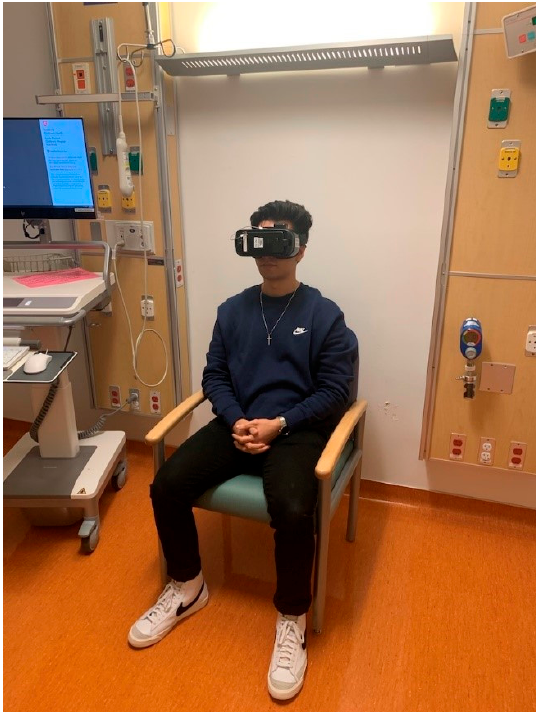
Figure 2. Mindfulness-Based Virtual Reality (MBVR) Application and Set-Up. The MBVR application was pre-loaded on a Samsung Gear VR headset equipped with a Samsung Galaxy S8 smartphone. Participants could engage with the MBVR experience sitting upright in a chair or supine in a medical exam bed.